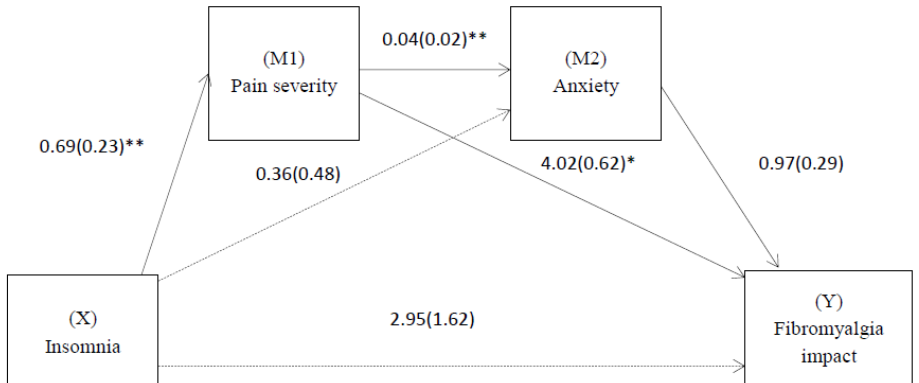
Figure 1. Path diagram illustrating direct effects and causal paths linking pain severity with the fibromyalgia impact. Notes: Multiple mediation analysis in series with the fibromyalgia impact as the dependent variable, insomnia as the independent variable and pain severity and anxiety as the first and second mediators. Values are non-standardized regression coefficients (SE in parentheses) and associated p values (* p < 0.05, ** p < 0.01). Association in brackets = direct effect (controlling for indirect effects). Solid lines indicate important pathways and dashed lines indicate non-significant